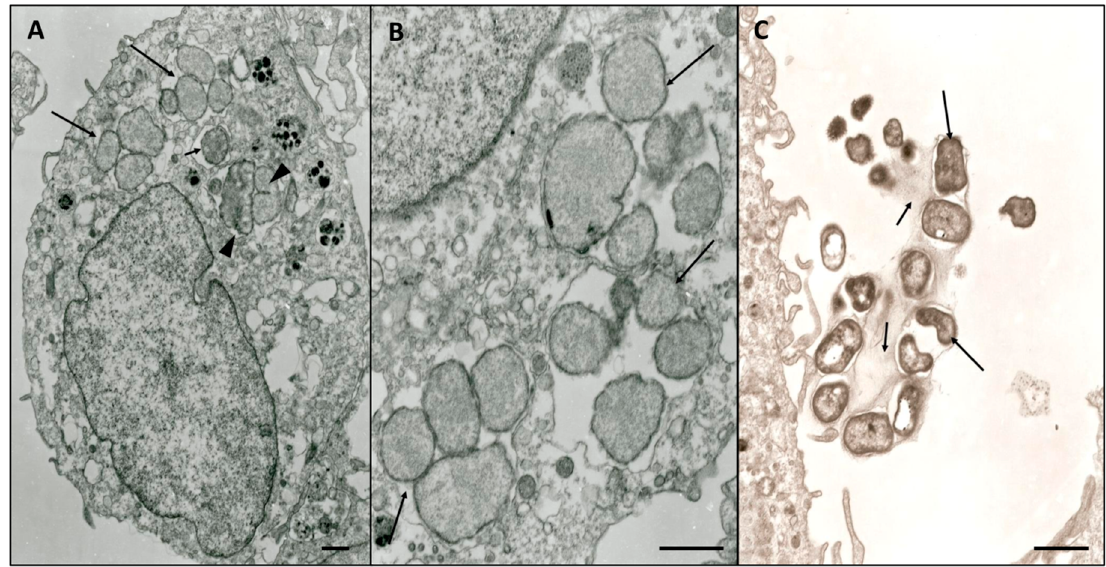
Figure 3. Electron micrograph of E. minasensis in DH82 cells. ( A ) Morulae were observed to contain reticulate cells (RC, large arrow), densely packed unique cell (small arrow), and cells dividing by unequal fission (head arrow). ( B ) RC bodies inside membrane-lined vacuoles were bound by an inner plasma membrane and an outer cell wall (arrow). ( C ) Dense-cored cells DC microorganisms (large arrow) surrounded by cellular plasmalemma (small arrow) after rupture of the host cell membrane. Bar = 1.0 µm.